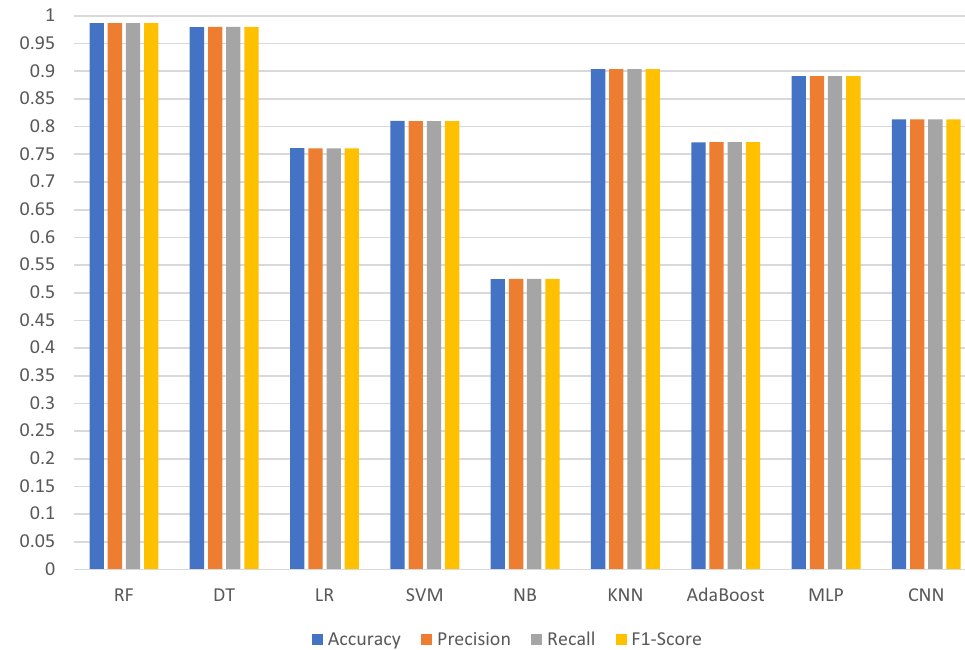
Fig. 5 Results with Huffman encoding-based feature vector